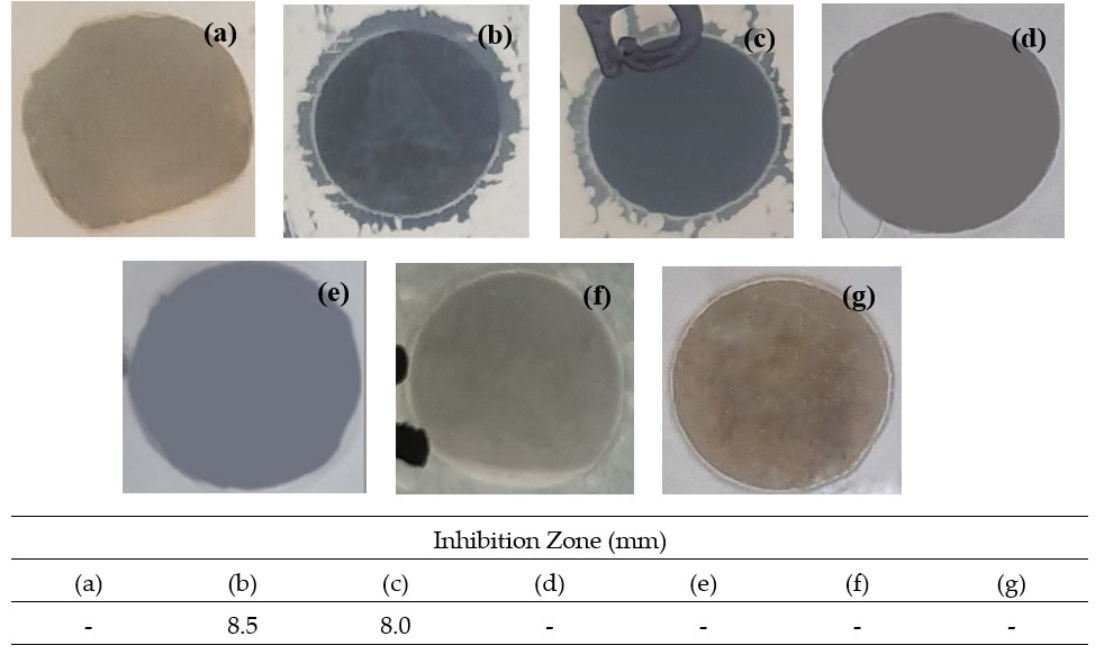
Figure 11. Inhibition zone images for antimicrobial activity of ( a ) CS, ( b ) 90/10CS/PLA-GO, ( c ) 70/30CS/PLA-GO, ( d ) 50/50CS/PLA-GO, ( e ) 90/10CS/PLA, ( f ) 70/30CS/PLA and ( g ) 50/50CS/PLA composites.